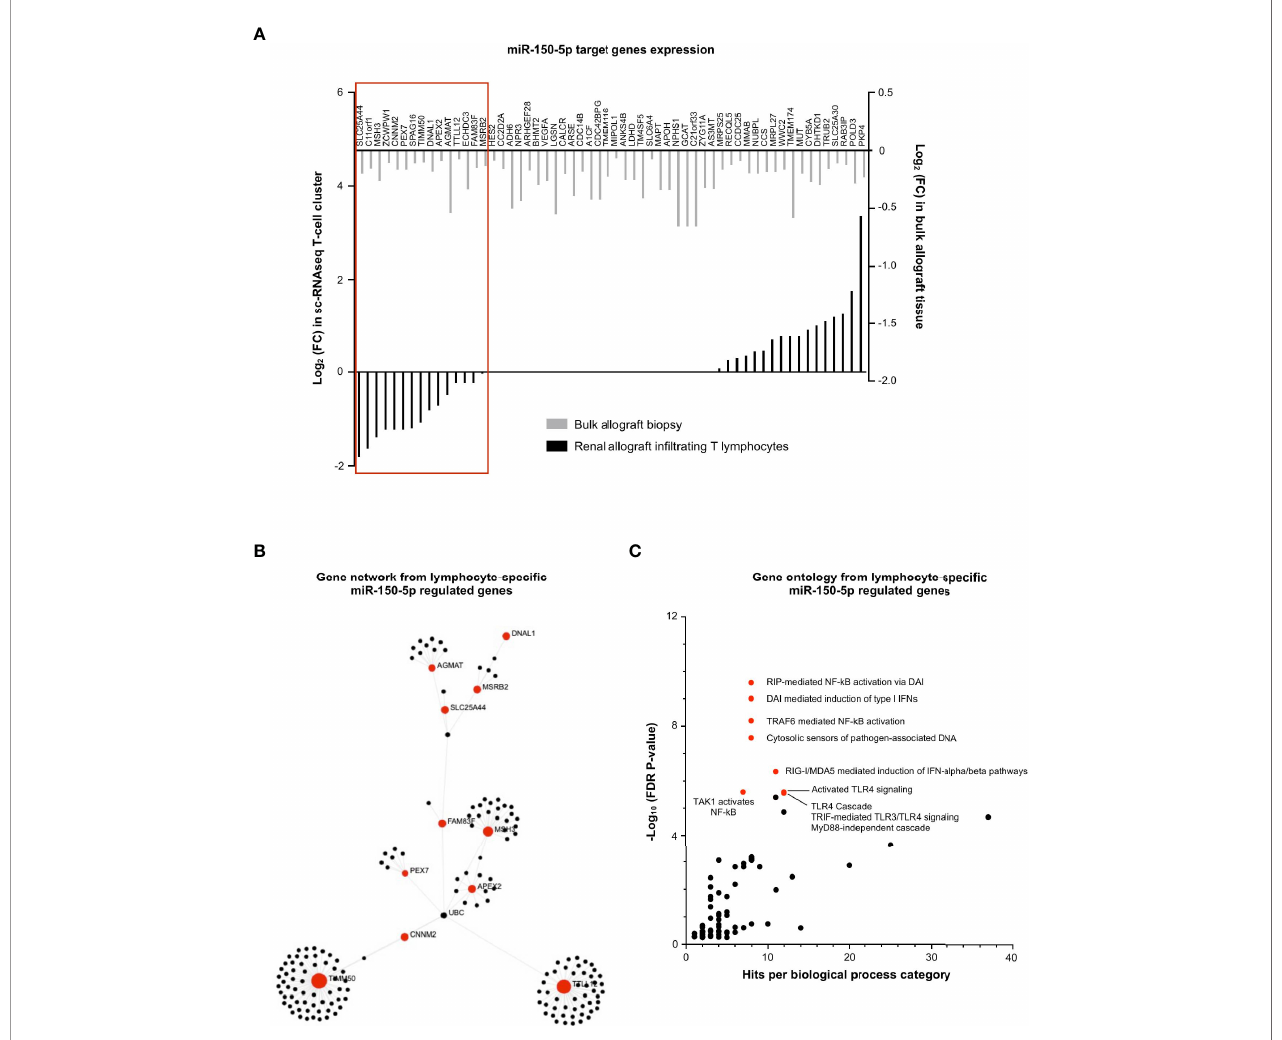
FIGURE 7 | miR-150-5p regulates NF- k B activation in T lymphocytes during MVI. (A) Bar plots showing the differential expression of each individual miR-150-5p target genes between MVI + and MVI- samples, in the bulk transcriptomic analysis (light gray) or in the T lymphocytes cluster from sc-RNAseq analysis (black). Red frame indicates 15 genes, concordantly downregulated in MVI in bulk tissue and in the T lymphocyte cluster. (B) Gene network corresponding to the 15 downregulated genes in MVI built on Omicsnet. (C) Gene ontology and pathway enrichment analysis based on Omicsnet and Reactome databases. The name of the top 10 enriched pathways in term of adjusted P-value are shown (red